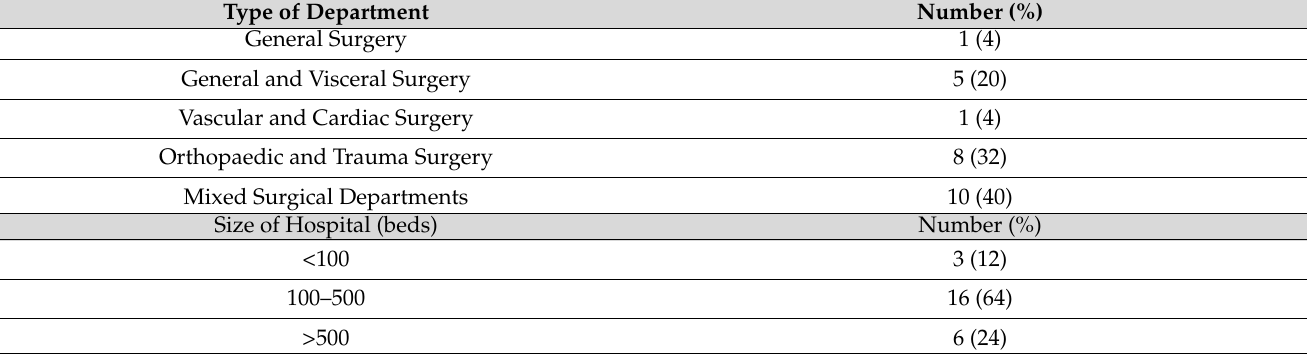
Table 1. Characteristics of surgical departments with HoD participating in the survey ( n = 25).